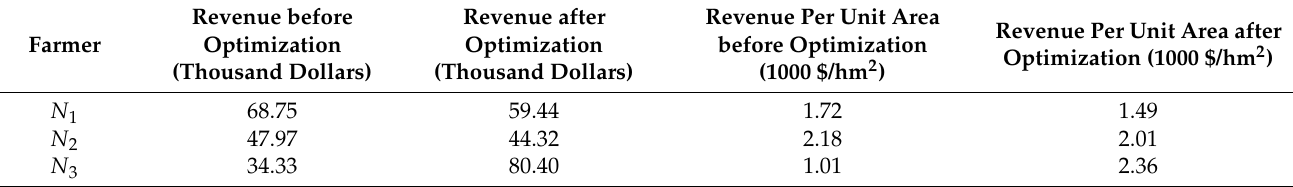
Table 4. Revenue before and after optimization plan M3.